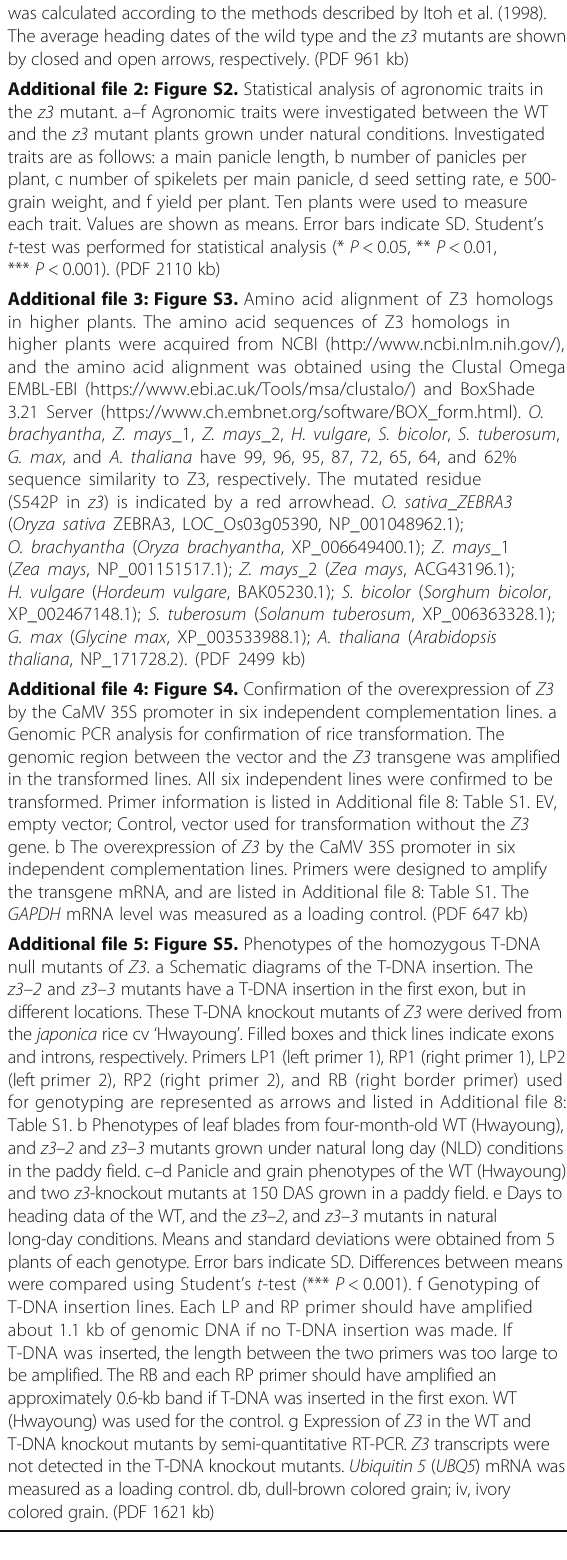
Additional file 1: Figure S1. Late flowering phenotypes of the z3 mutant. a Flowering phenotypes of the 117-day-old WT and z3 mutant grown under natural long day conditions (14 h light/day, 37o N latitude) in the paddy field. b Days to heading of the WT and the z3 mutant in natural long day conditions. Means and SD were obtained from 15 plants of each genotype. Error bars indicate SD. Differences between means were compared using Student ’ s t -test (*** P < 0.001). c Comparison of leaf